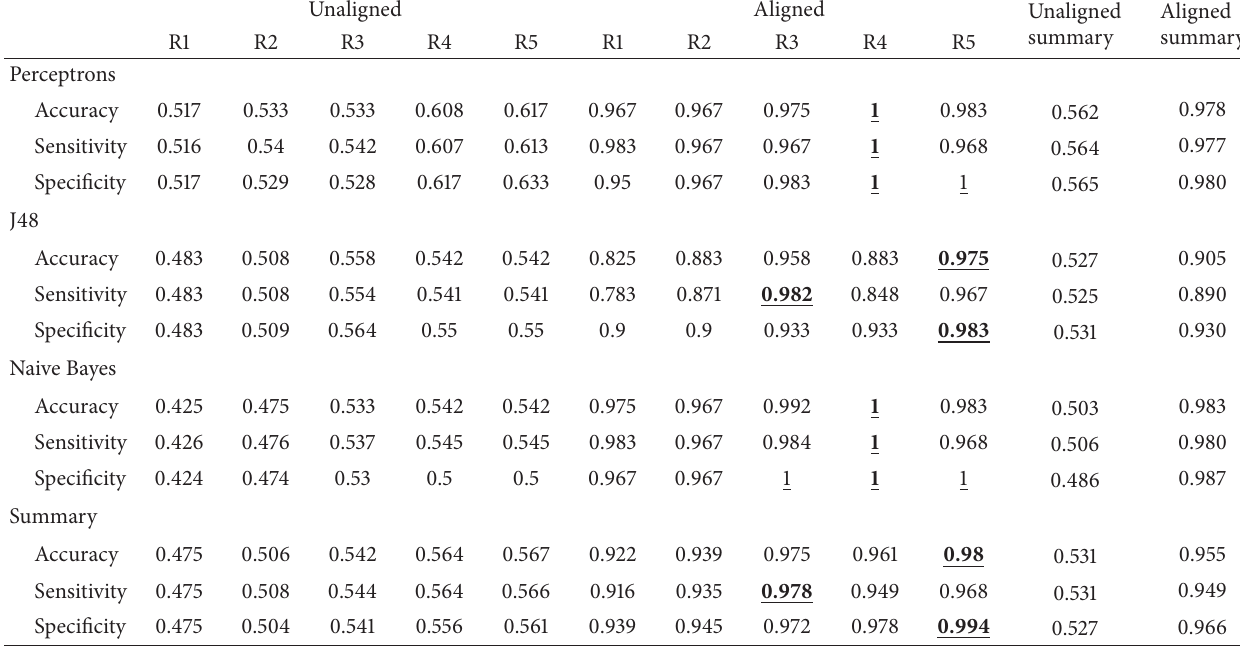
Table 3: Results of 50:50 train-test ratio, 10-fold cross-validation on all five representations, non-aligned and aligned, using perceptrons, J48 and Naive Bayes.